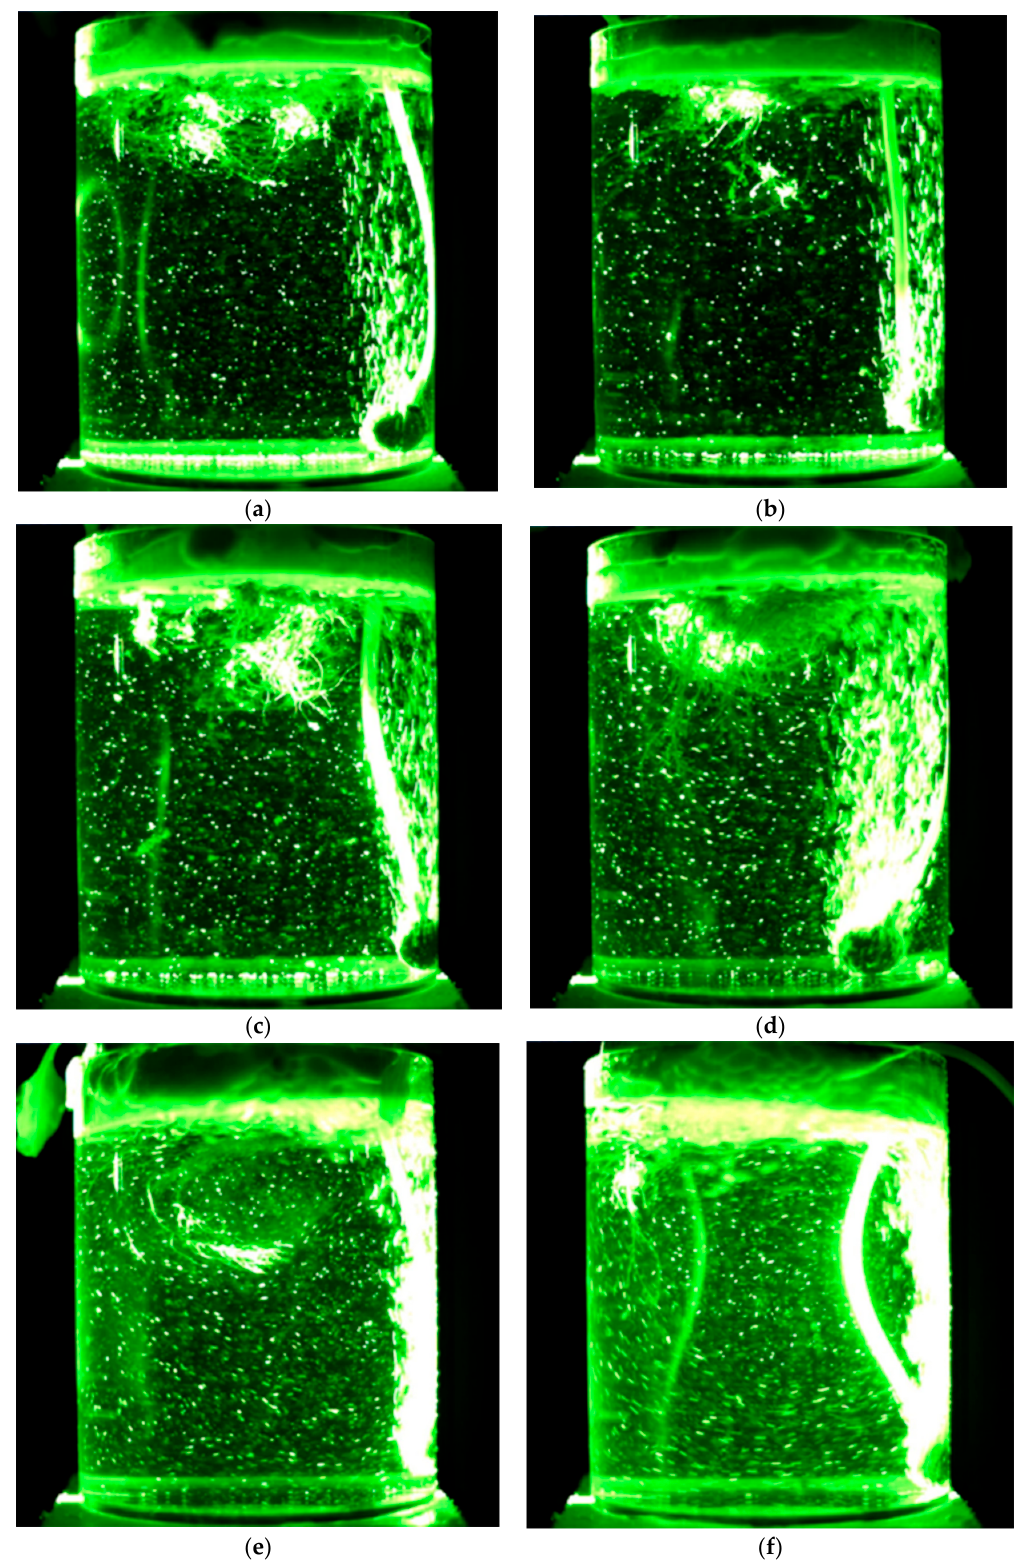
Figure 8. Bubble flow fields under different aeration intensities: ( a ) aeration intensity = 0.07 L·L − 1 NS·min − 1 , ( b ) aeration intensity = 0.15 L·L − 1 NS·min − 1 , ( c ) aeration intensity = 0.29 L·L − 1 NS·min − 1 , ( d ) aeration intensity = 0.59 L·L − 1 NS·min − 1 , ( e ) aeration intensity = 1.18 L·L − 1 NS·min − 1 , and ( f ) aeration intensity = 2.35 L·L − 1 NS·min − 1 .